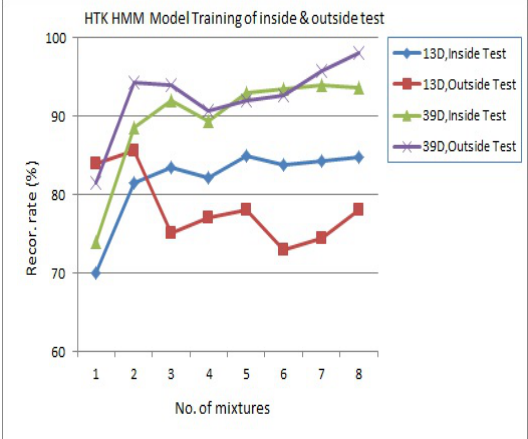
Figure 25. HMM model